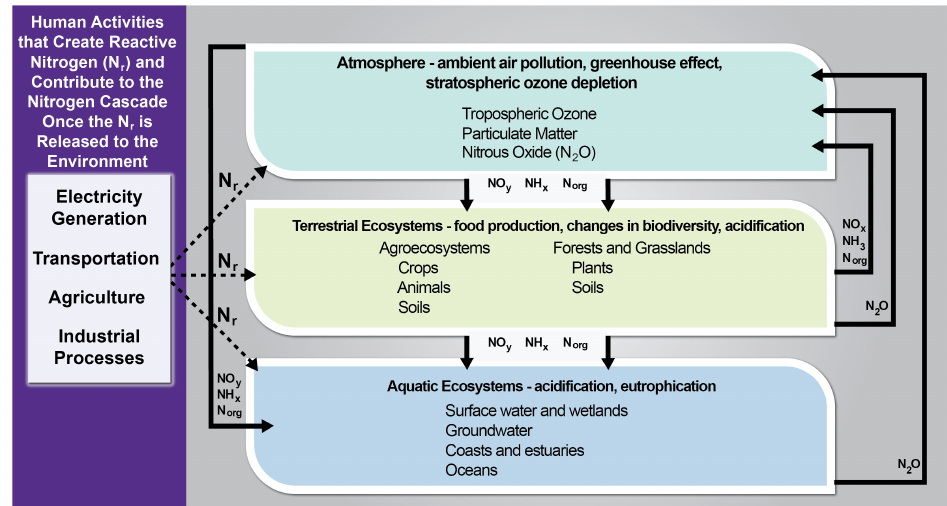
Figure 2. Human activities that form reactive nitrogen, and resulting consequences in the envi- ronment. [Image credit: Galloway et al., Climate Change Impacts in the United States: The Third National Climate Assessment; Technical Report (U.S. Global Change Research Program; 2014)